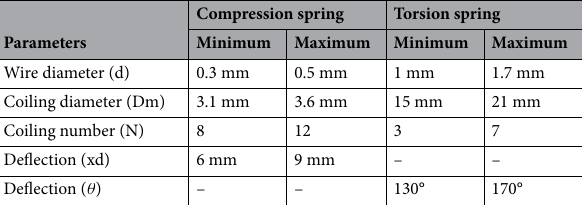
Table 1. Parameters of the compression